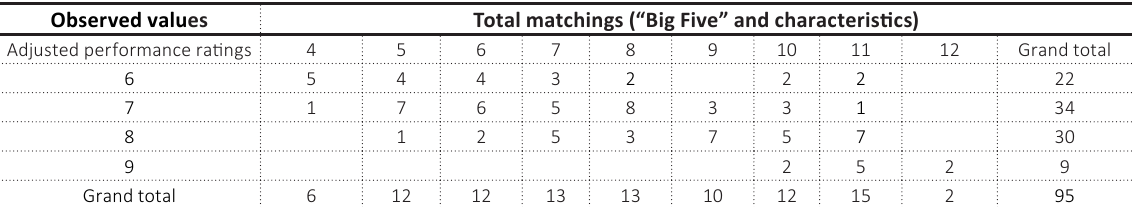
Table 5. “Expected frequencies” of matching vis-à-vis performance ratings Expected values Total matchings (“Big Five” and